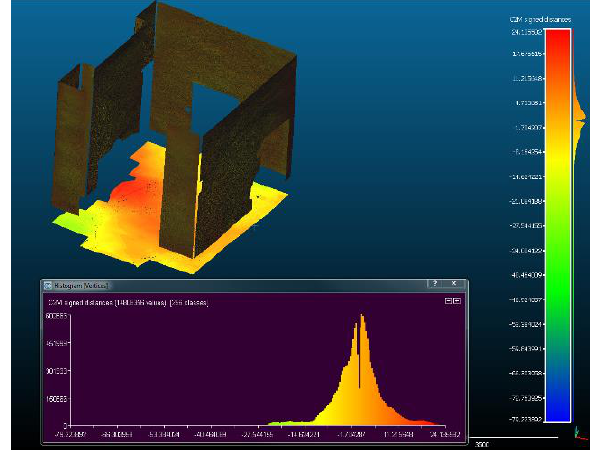
Figure 3. Re-assembled decimated meshes compared to perfect flat planes